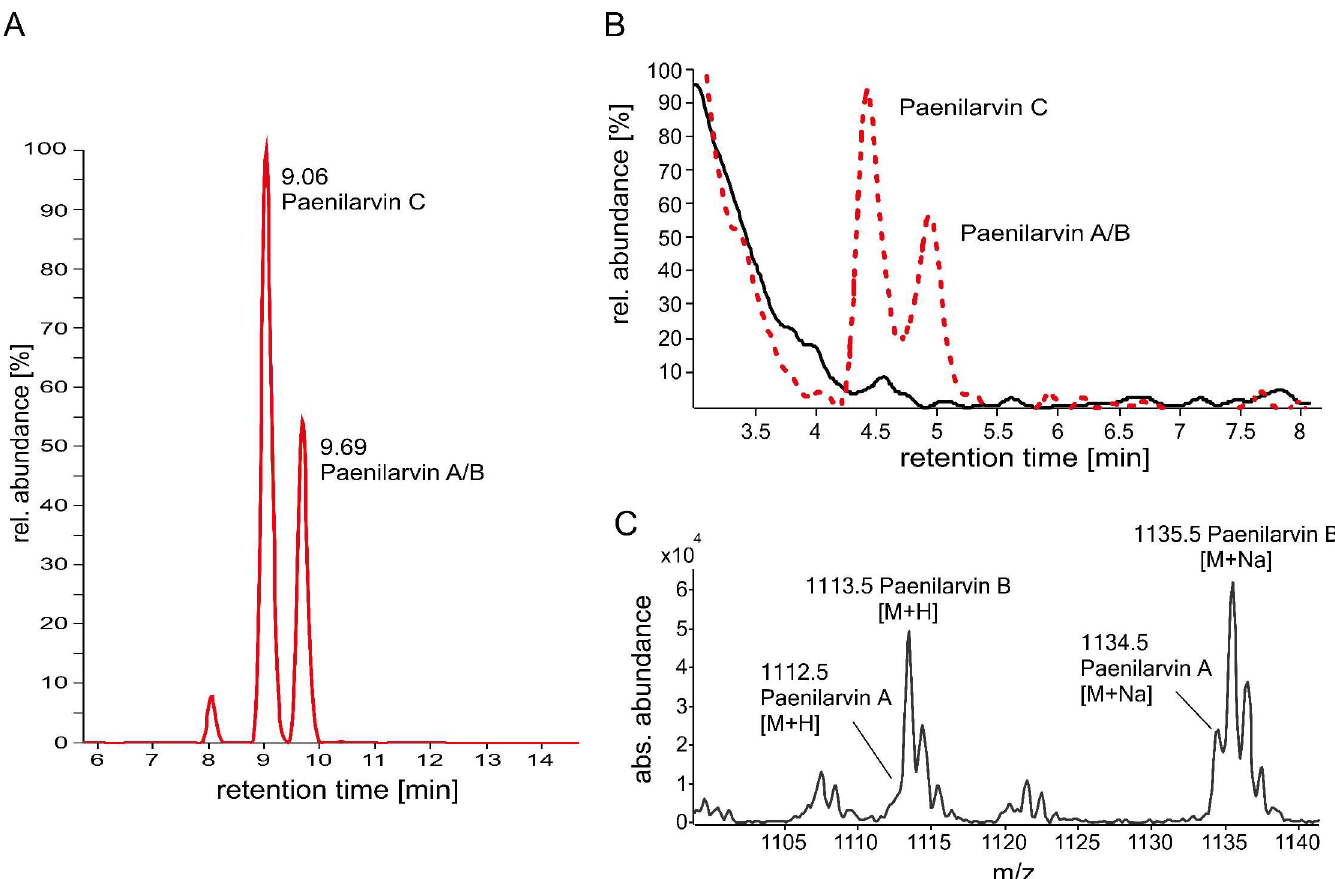
Fig 1. Identification of the paenilarvins in infected larvae and in P . larvae secretomes. (A) Extracted ion chromatogram (EIC) for paenilarvins detected in experimentally infected bee larvae. Paenilarvinsappear at retention times R t = 9.06 and R t = 9.69 minutes; the peak at 8.00 min does not correspondto the paenilarvins. The figure is representative for 4 independent experiments.(B) EICs for paenilarvinsA/B/C of culture supernatants of P . larvae DSM25430wt (red dotted line) producingpaenilarvins and the knockout mutant P . larvae DSM25430 Δ itu (solid black line) not able to produce paenilarvins. (C) Masses for paenilarvinsA/B extracted from the corresponding peak (R t = 5 min) in (B).